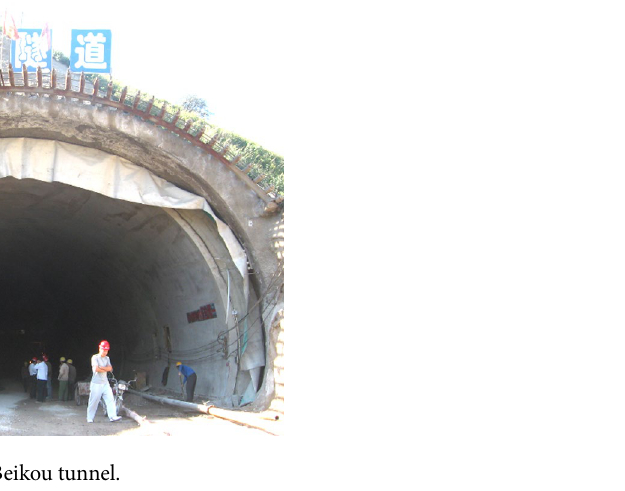
Figure 2. Left entrance of the Beikou